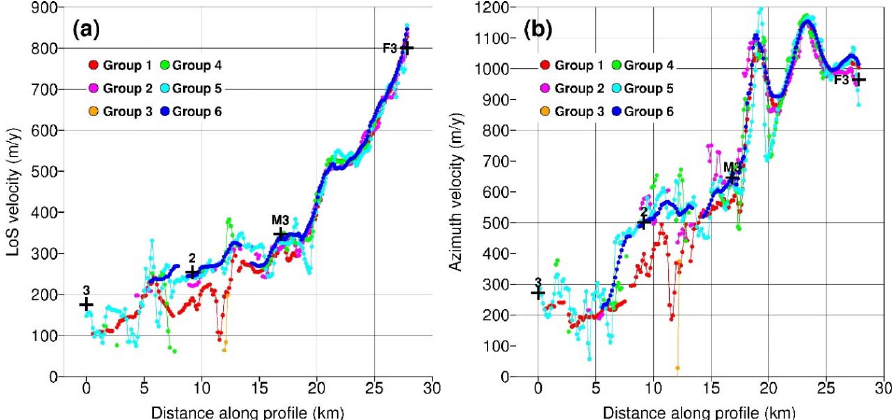
Figure 14. Task 3 velocity profiles along the dashed line in Figures 12 and 13. Crosses represent the projected GPS LoS and azimuth velocities for the stations intersected by the profile. Colors represent the results of groups 1 to 6. Table 8. Task 3 validation statistics.